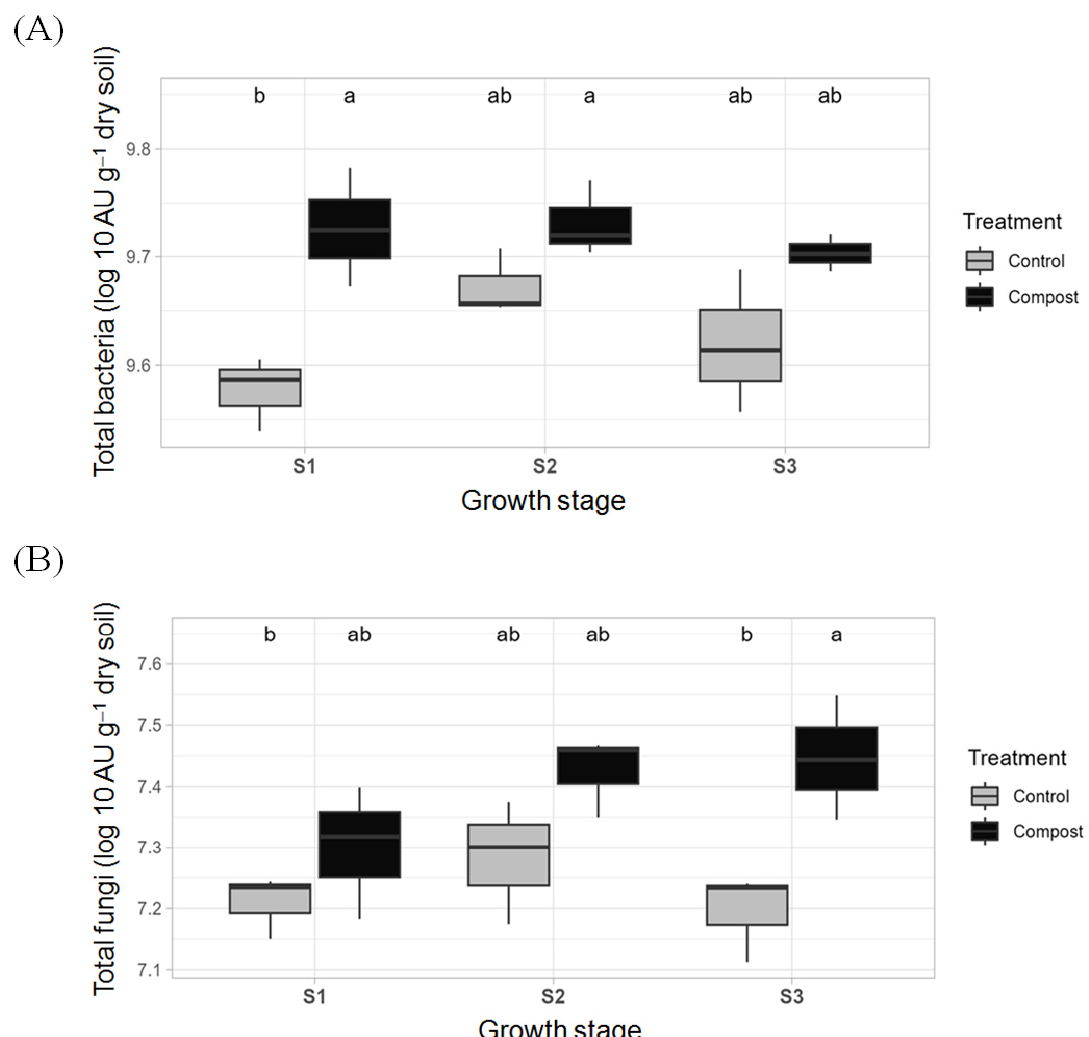
Figure 1. Quantitative PCR (qPCR) measurements of bacterial abundances ( A ) and fungal abundances ( B ) in the soils that grew barley without or with date palm waste compost at tillering (S1), booting (S2) and ripening stage (S3). Different letters above columns indicate significant differences ( p < 0.05, Duncan’s